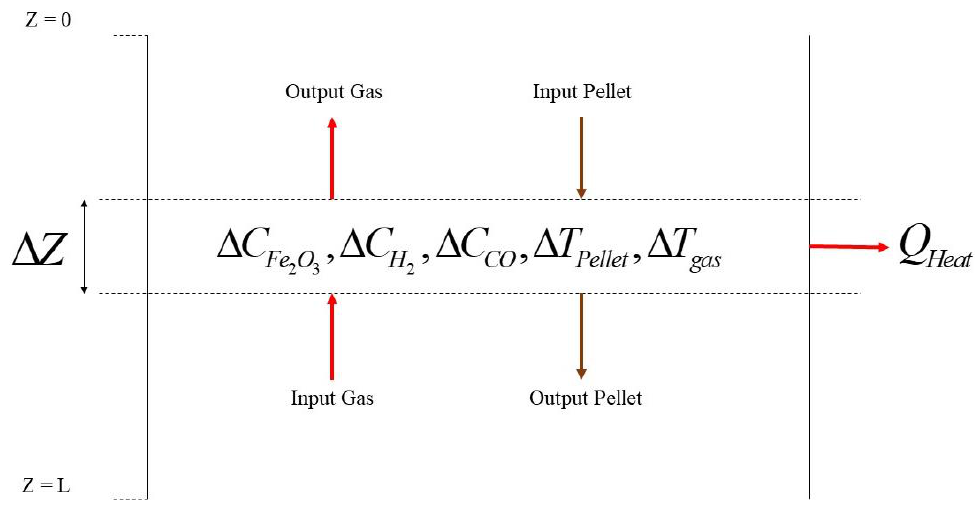
Figure 4. Schema of control volume around the reduction zone.